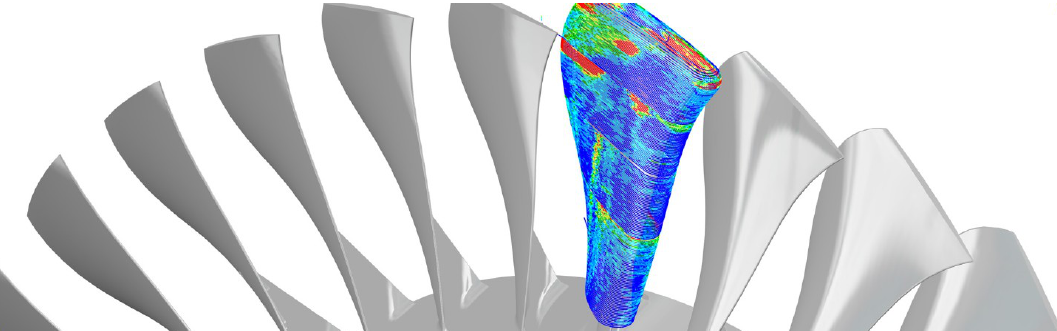
Figure 4. An illustration of DT in manufacturing: CM in the networked, adaptive production [165]. © Fraunhofer